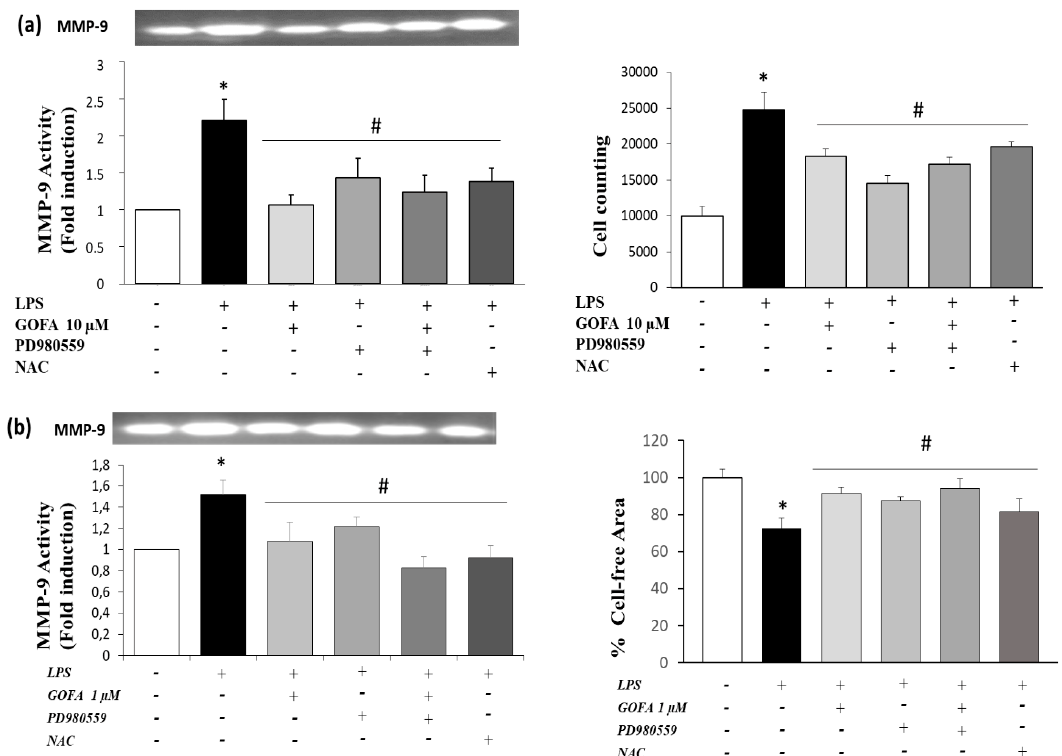
Figure 9. Effects of pharmacological inhibitors on MMP-9 activation and migration in U937 (A) and HCT-116 (B) cell lines. Cells were treated or not with GOFA, selective inhibitor of ERK (PD980559) and ROS (NAC). ( a ) MMP-9 activity by zymography (left) and numerical representation of the cell flow/min (right) in the different experimental conditions of U937 cells. * p < 0.05 vs control cells; # p < 0.05 vs. LPS treated cells Data are reported as fold induction values (mean ± SD, n = 6). * p < 0.05 vs cells treated with LPS alone. ( b ) MMP-9 activity by zymography (left) and histogram bar of scratch closure measuring the remaining cell-free area expressed as percentage of the initial cell-free area (right). * p < 0.05 vs control cells (T 0 ); # p < 0.05 vs cells treated with LPS alone. The values are presented as the mean ± SD of three independent